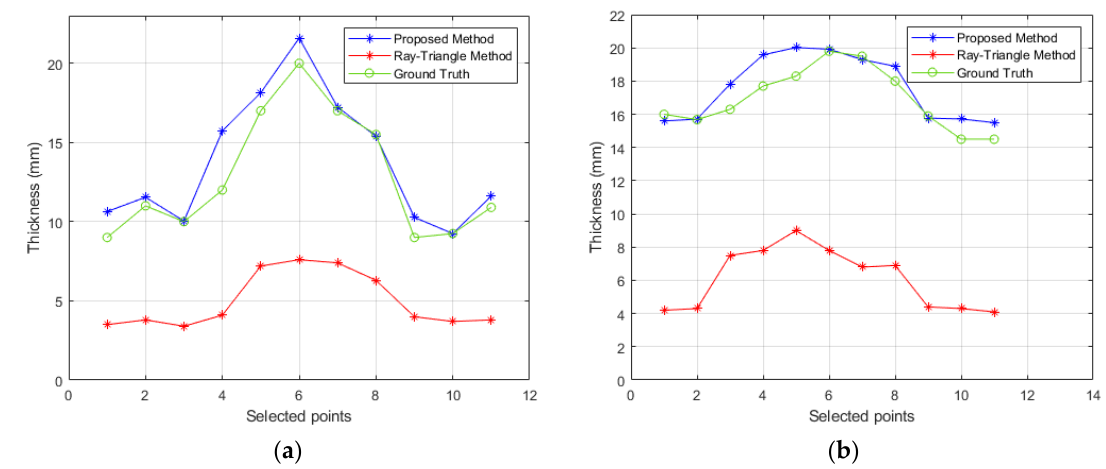
Figure 17. The proposed method based on thermal analysis, the Ray-Triangle method, and the manual measurement results: ( a ) skull thickness values obtained from left temporal bone to right temporal bone; ( b ) skull thickness values obtained from the frontal bone to the parietal